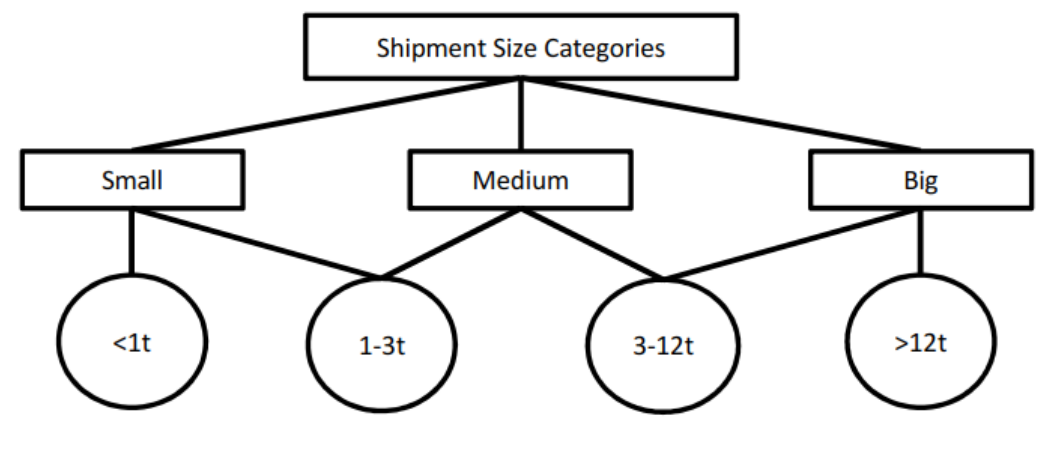
Figure 3: Structure of the cross-nested logit